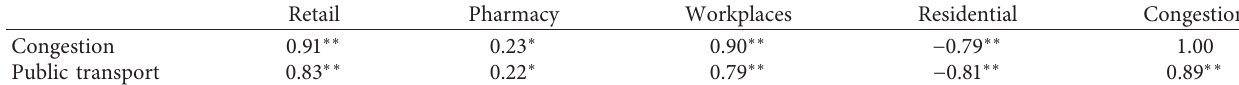
Table 2: Correlation among activity, congestion, and public transport demand data.